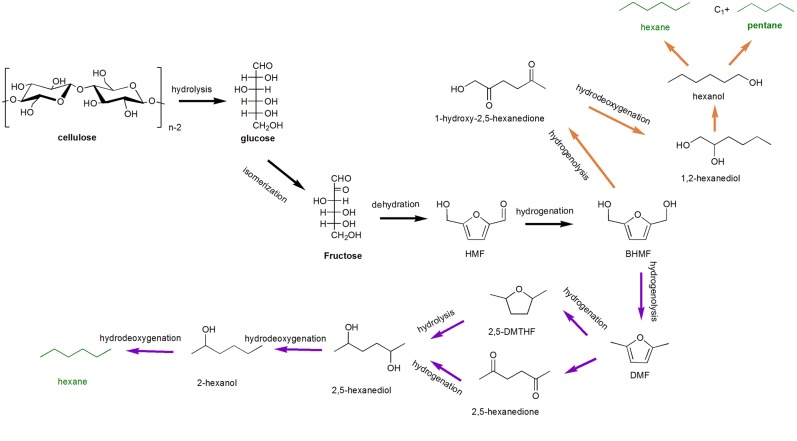
Probable pathway of cellulose conversion to pentane and hexane via 5-hydroxymethylfurfural (HMF).